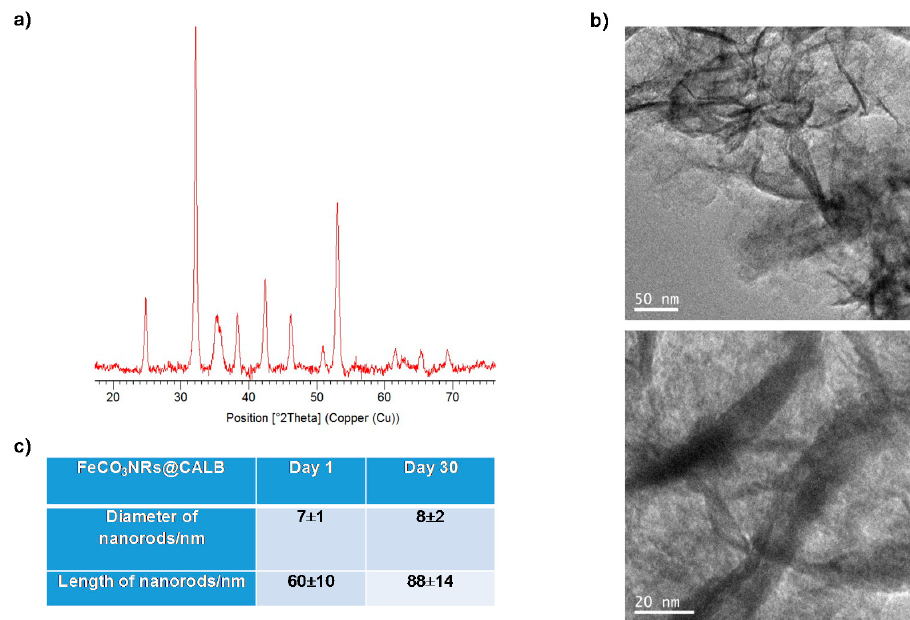
Figure 5. Characterization of FeCO 3 NRs@CALB after 30 days. ( a ) XRD pattern nanocomposite. ( b ) TEM images of the nanocomposite. ( c ) Comparison of nanorods size of the nanocomposite at day 1 and day 30 after synthesis.